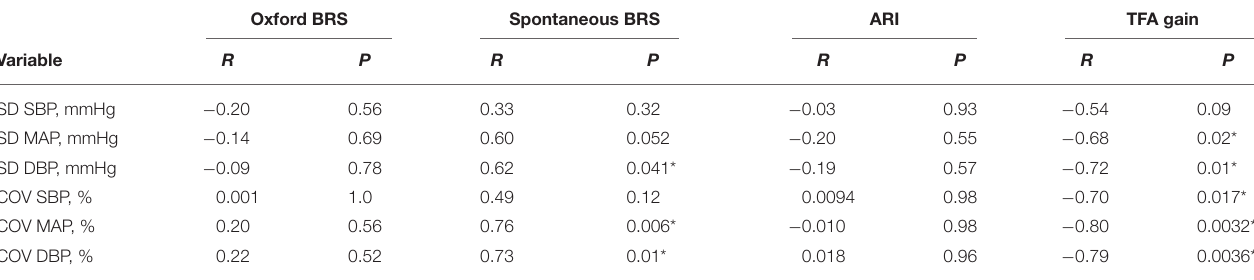
TABLE 2 | Relationships between BPV and sympathetic arterial BRS and CA. Oxford